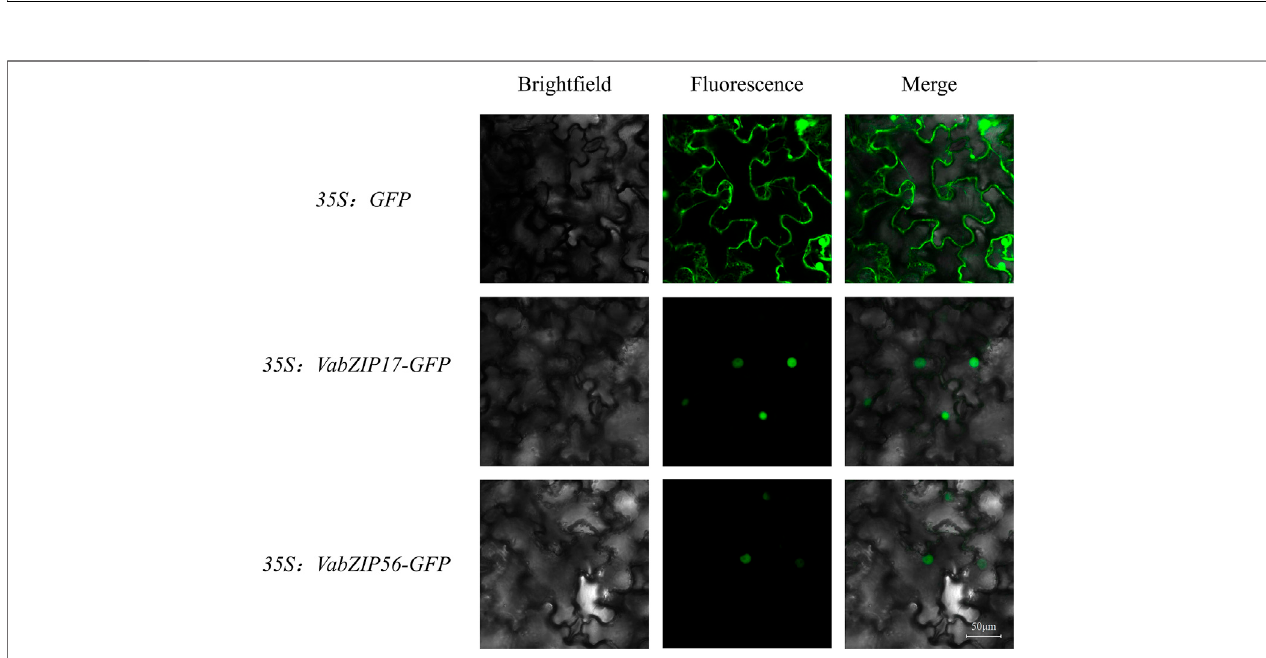
FIGURE 6 | Collinearity analysis of VabZIPs. (A) Collinearity of PvHsf members. The red PvHsfs indicate collinearity while the black ones have no collinearity. The middletworingsindicategenedensity. Thegraybackgroundlineindicatesacollinearbackgroundwhilethegreenlinesindicateacollinearrelationship. (B) Collinearityof VabZIPs with Arabidopsis . Red boxes are the chromosomes of Arabidopsis while the green boxes are the chromosomes of the adzuki bean. The gray lines indicate the collinearity background while the red lines indicate collinearity between VabZIPs and Arabidopsis members.